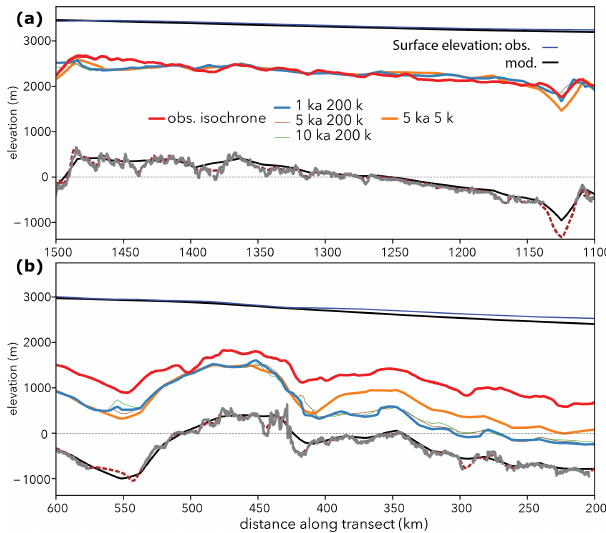
Figure 3. Observed and simulated isochrones along transect CEA- 10 (see Fig. 10 for the location of transect CEA-10). Observed isochrone is shown in red; simulated isochrones are computed based on snapshot velocity fields every 1, 5 and 10kyr. Tracer seeding was carried out with 200000 and 5000 tracers. Bedrock and surface el- evation in the model runs is plotted in black, observed surface el- evation in dark blue, and bedrock elevation derived from the radar transect in grey. The gridded 1km BedMachine bedrock elevation (Morlighem et al., 2020) is plotted for comparison as well (smooth dashed red